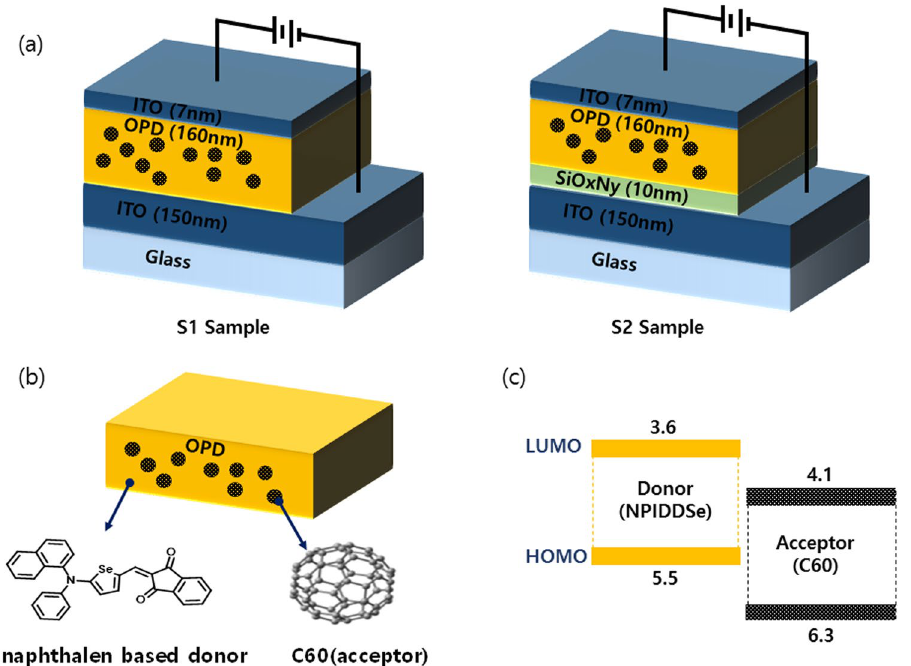
Figure 1. ( a ) Structure of the OPD device with and without SiOxNy buffer layer. ( b ) Chemical structure of blend organic film ( c ) HOMO and LUMO energy values of blend organic